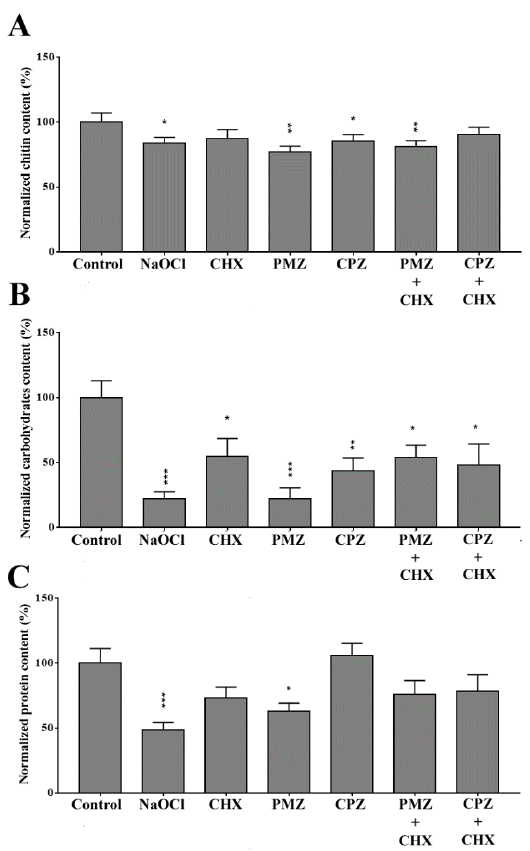
Figure 3. Normalized chitin ( A ), carbohydrate ( B ) and protein ( C ) content of the dual-species biofilms after treatment for 10 min with sterile saline (control); 25 mg/mL NaOCl; 20 mg/mL CHX; 1.28 mg/mL PMZ; PMZ+ CHX, 0.08 mg/mL + 0.02 mg/mL; 0.5 mg/mL CPZ; CPZ + CHX, 0.125 mg/mL + 0.02 mg/mL. * represents statistically significant differences compared to the control. * represents p < 0.05, ** represent p < 0.01, and *** p < 0.001. Data are expressed as mean ±SD.